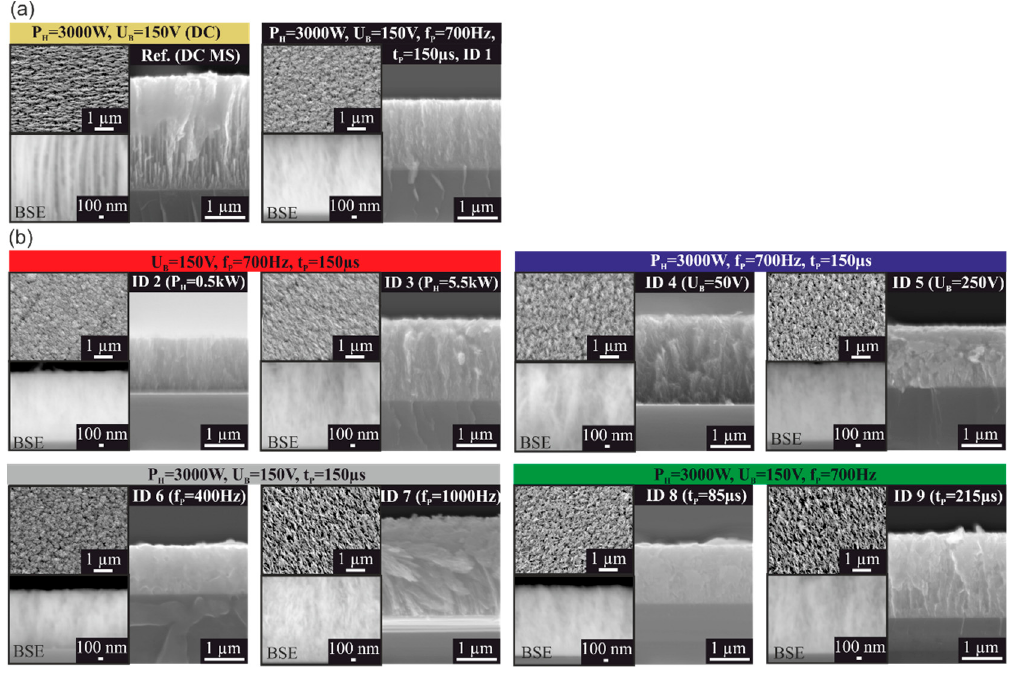
Figure 2. SEM images of the strucutre of ( a ) a DC (yellow) and HiPIMS (black) grown MoS x thin film and ( b ) HiPIMS grown MoS x thin films with varied heating power (red), bias-voltage (blue), pulse frequency (grey), and pulse duration (green). The topography of the thin films is shown in the top left inset, and the morphology in the right inset. Magnified cross-section images in backscattered-electron (BSE) mode (bottom left) show details of the morphology.